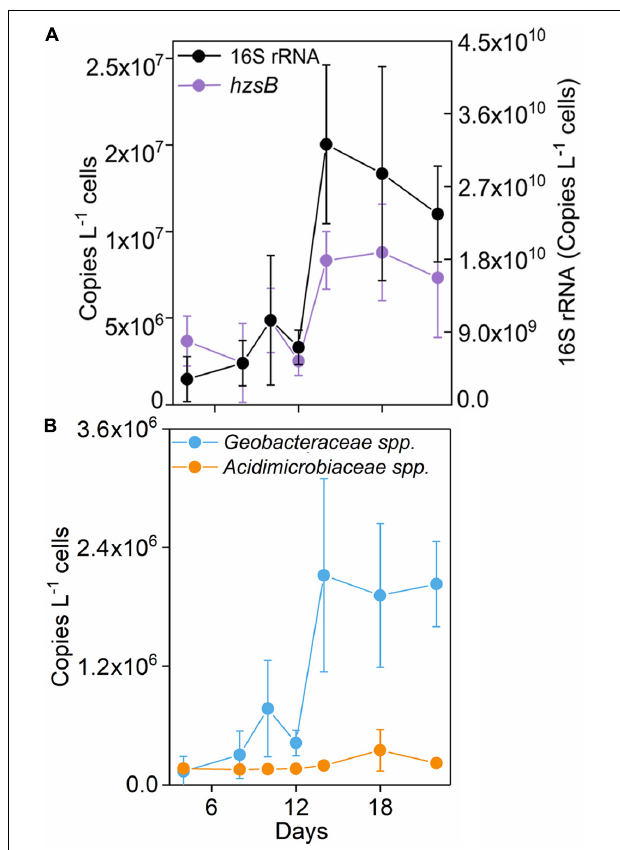
FIGURE 2 | Copy numbers of 16S rRNA gene, and nosZ (A) , Geobacteraceae spp., and Acidimicrobiaceae spp. (B) in the treatment of Fe(III) + NH 4 + during 22-day incubation. Error bars represent standard deviations of three replication.